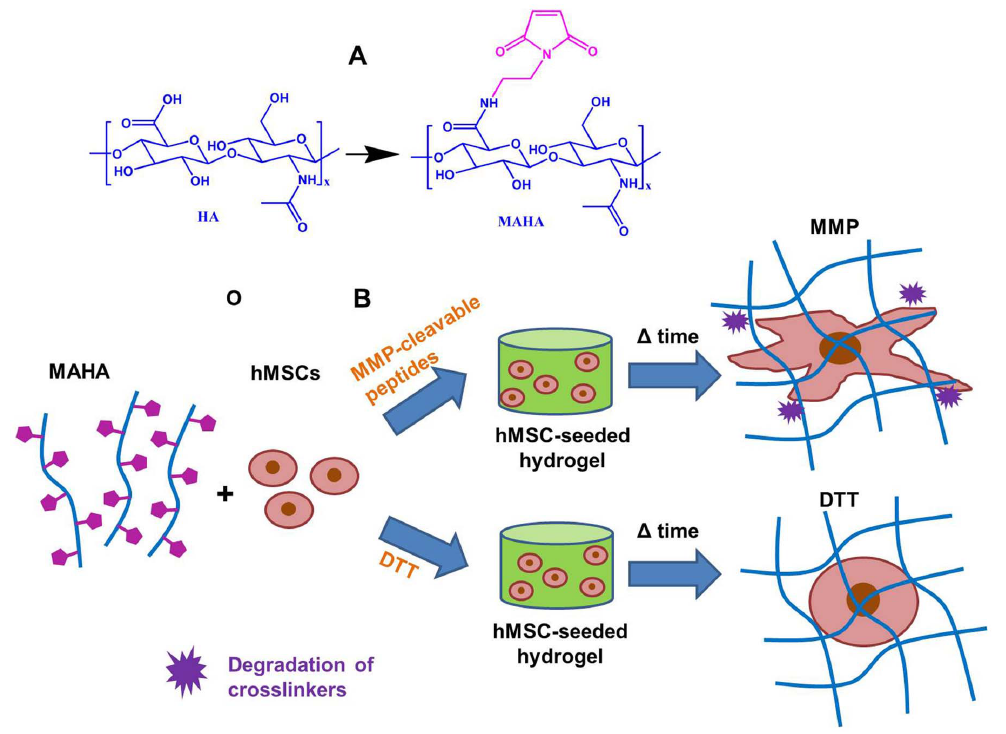
Figure 1. The chemical structure of the maleimide modified HA (MAHA) and encapsulation of hMSCs in MAHA hydrogels. (A) Modification of hyaluronic acid to yield maleimide modified HA (MAHA). (B) Encapsulation of hMSCs in MAHA hydrogels using either MMP-cleavable peptides or MMP-insensitive DTT as crosslinkers.